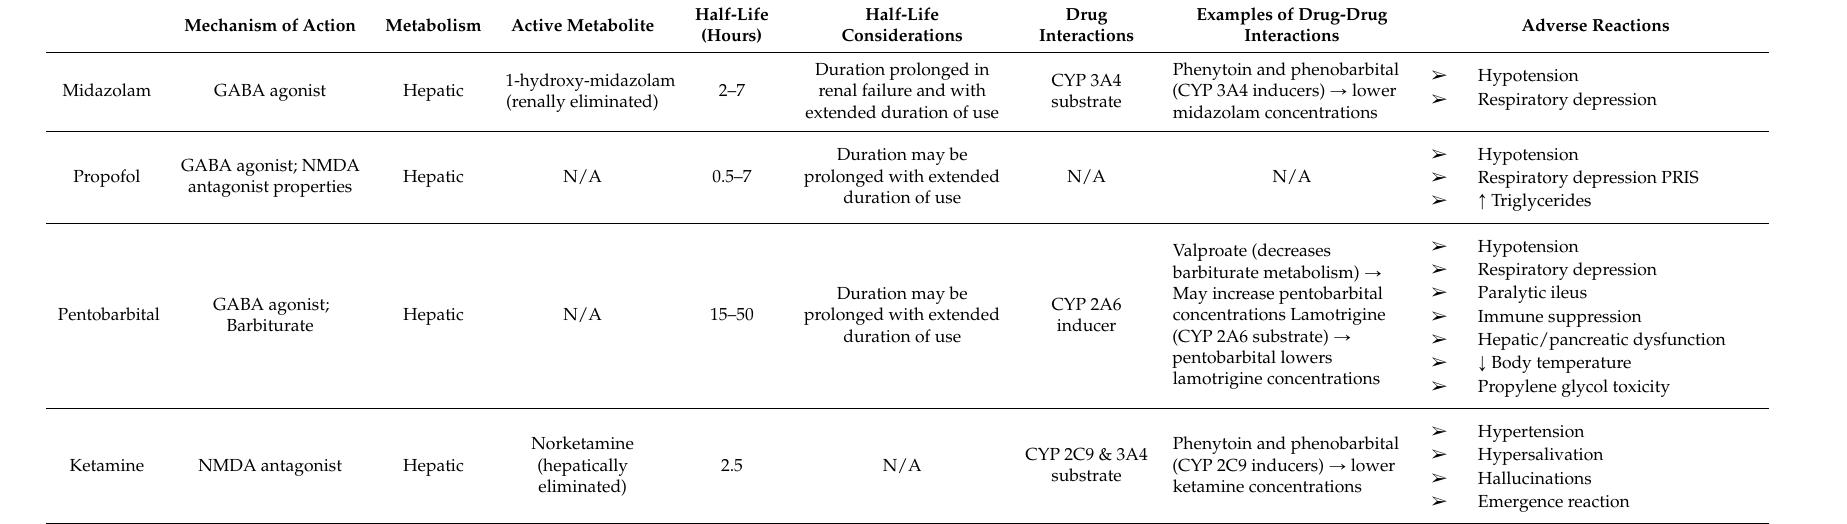
Table 1. Pharmacology of Commonly Used CI Anesthetics for